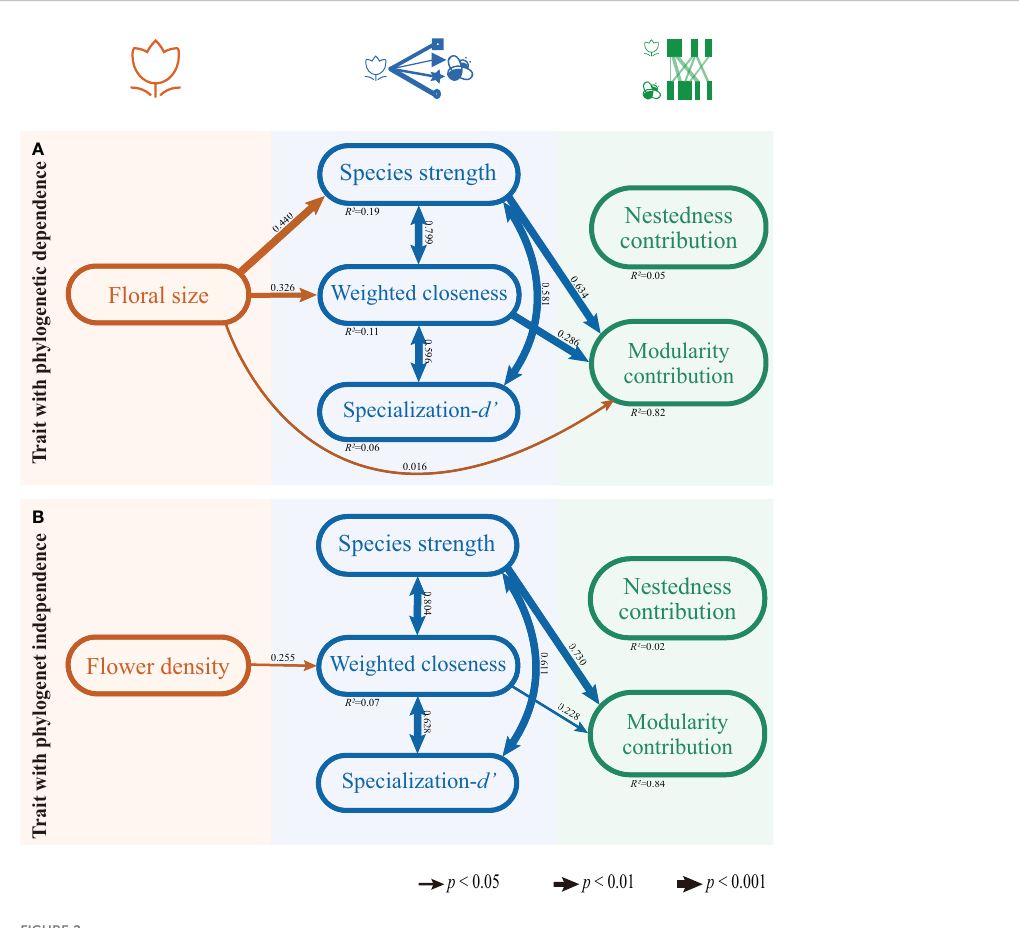
FIGURE 2 The SEMs showing how fl oral traits in fl uence network metrics in the transect. (A) shows that the pattern of fl oral size, with phylogenetic constraints, has in fl uences on the plant – pollinator network by PGLS, and (B) shows that fl ower density, with phylogenetic independence, has effects on the plant – pollinator network via GLMs. Paths among variables included in the model are shown. The solid arrows indicate a positive effect of a variable on another. Standardized path coef fi cient was given on each